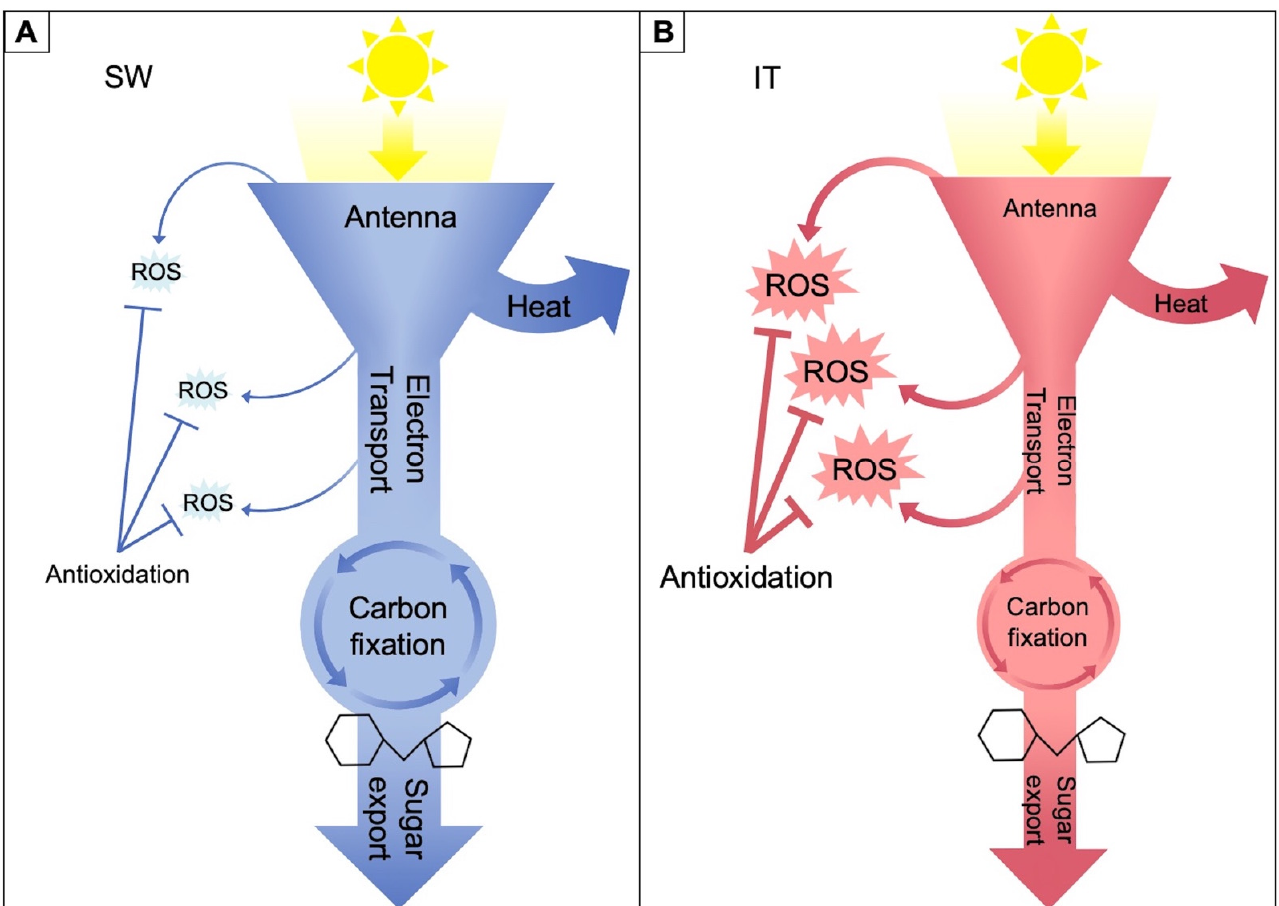
Figure 2. Schematic depiction of relative differences in capacities for light-harvesting (antenna), photoprotective dissipation of excess excitation energy as heat, electron transport, carbon dioxide fixation, sugar export (sucrose symbol), and ROS production and detoxification in leaves of the ( A ) SW and ( B ) IT ecotypes of A. thaliana .